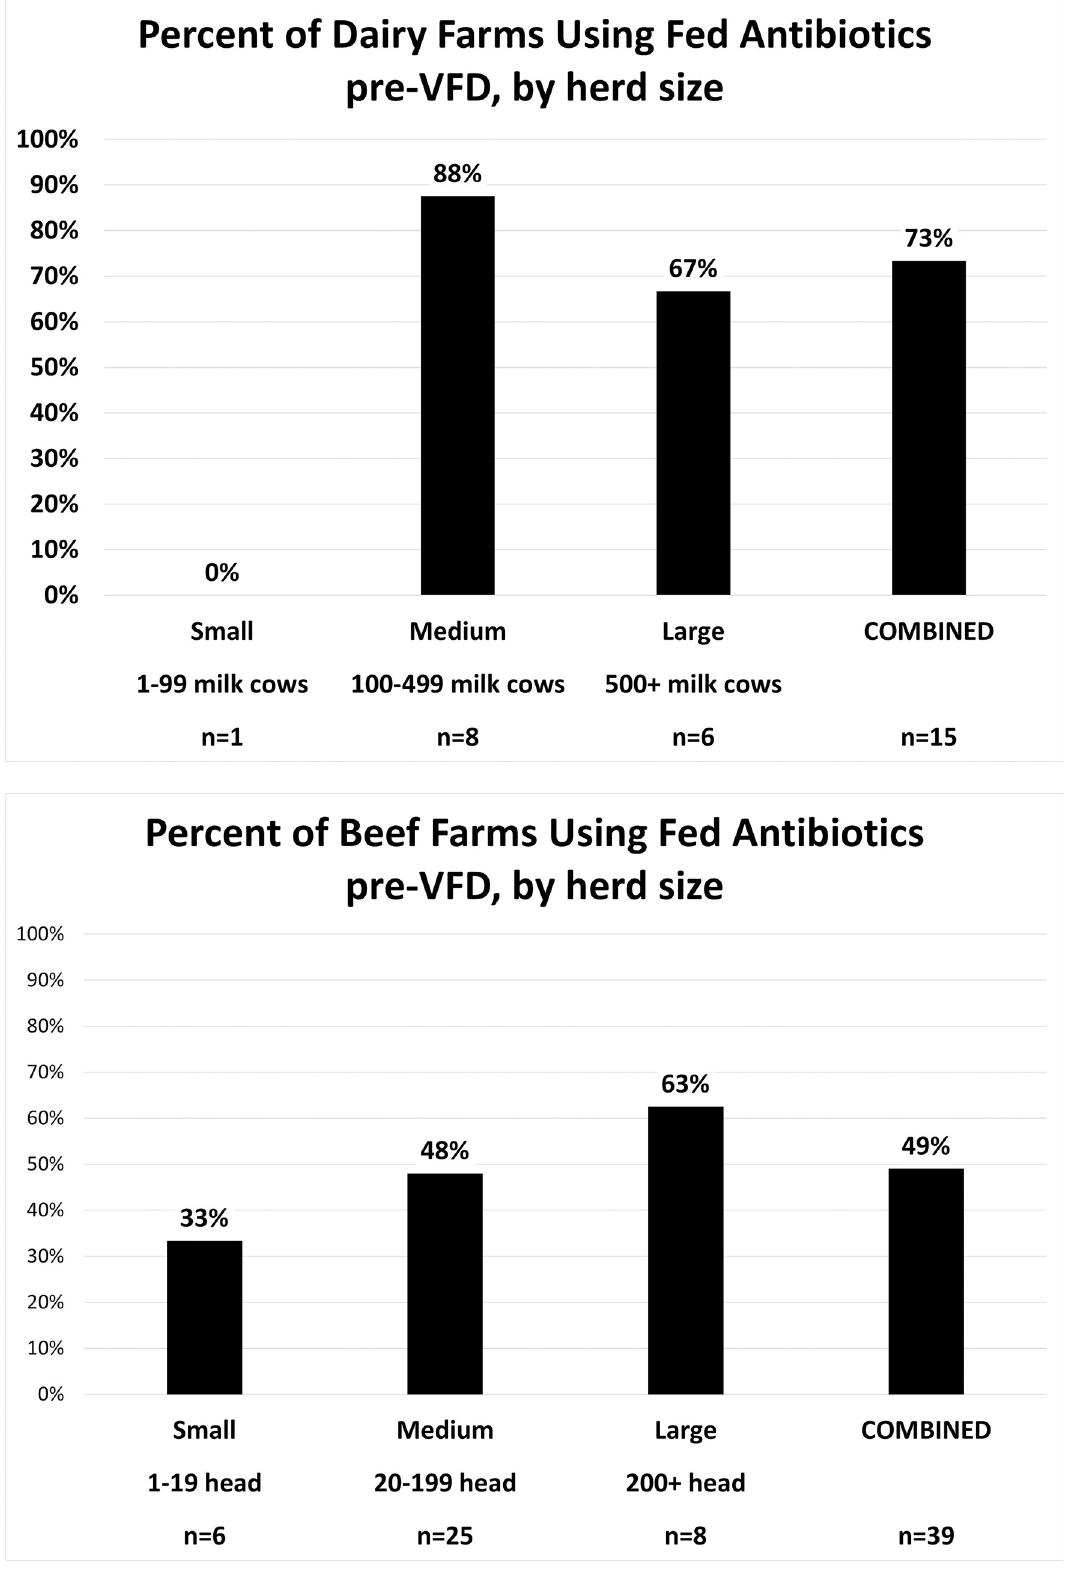
Fig 3. Use of fed antibiotics by Ohio cattle operations, percent by herd size. a. Dairy (size of milking herd) b. Beef (total head). https://doi.org/10.1371/journal.pone.0255911.g003 PLOS ONE | https://doi.org/10.1371/journal.pone.0255911 August 9,